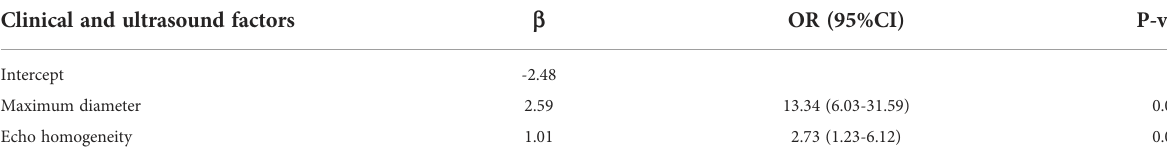
TABLE 2 Positive clinical and ultrasound factors of multivariate logistic regression analysis for GISTs.